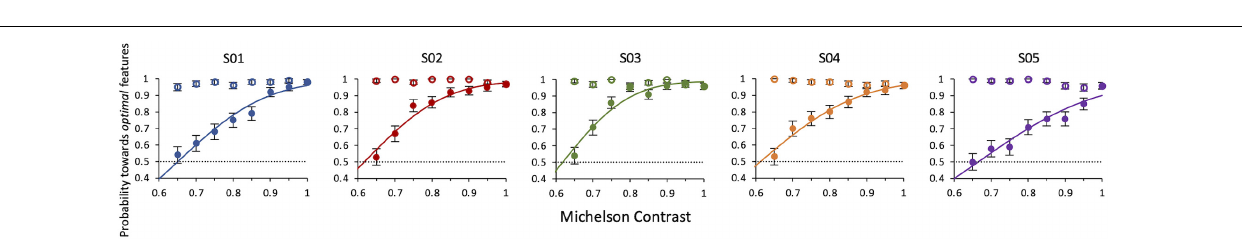
FIGURE 7 | Experiment 4: Probability of selecting the target as a function of relative contrast of target or distractor. Data from individual observers. Filled symbols: the contrast of the target is varied. Open symbols: the contrast of the distractor is varied. The line is the ML best fit. Individual thresholds are given by contrast values corresponding to 50% level performance and are, respectively, 0.65 ± 0.01, 0.62 ± 0.006, 0.62 ± 0.01, 0.61 ± 0.01, 0.67 ± 0.01.